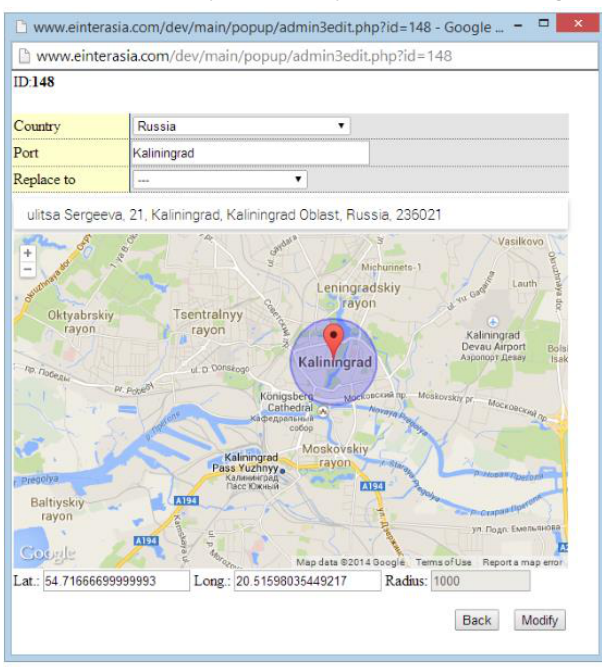
Fig. 5. Radius and areas around points of departure and destination.